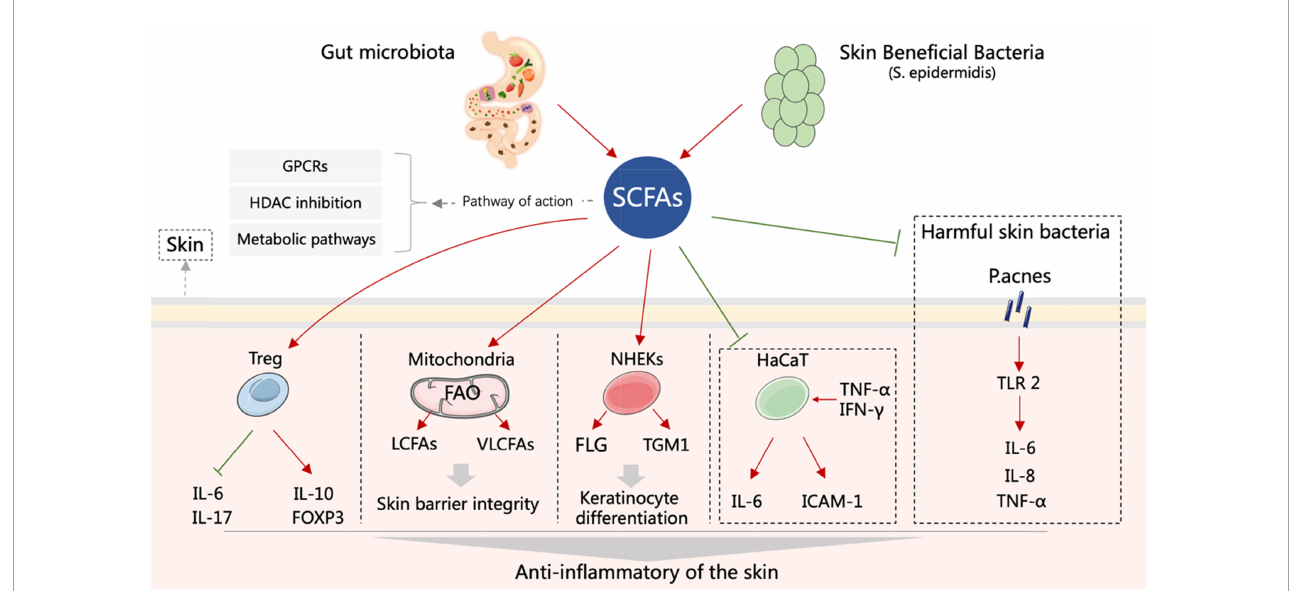
FIGURE1 Schematic representation of the roles of SCFAs in inflammatory skin diseases. Both gut and skin microbiota can produce SCFAs. SCFAs can enhance the activity of Treg, improve mitochondrial metabolism, promote keratinocyte differentiation, reduce the expression of inflammatory factors in HaCaT cells, and inhibit the inflammatory response induced by P. acnes that results in skin inflammation relief and skin barrier improvement. FLG, filaggrin; FOXP3, forkhead box protein 3; GPCRs, G protein-coupled receptors; HaCaT, human immortalized keratinocytes; ICAM-1, intercellular adhesion molecule-1; IFN- γ , interferon- γ ; IL-6, interleukin-6; IL-8, interleukin-8; IL-10, interleukin-10; IL-17, interleukin-17; LCFAs, long-chain fatty acids; NHEKs, normal human epidermal keratinocytes; P. acnes , Propionibacterium acnes ; S. epidermidis , Staphylococcus epidermidis ; SCFAs, short chain fatty acids;